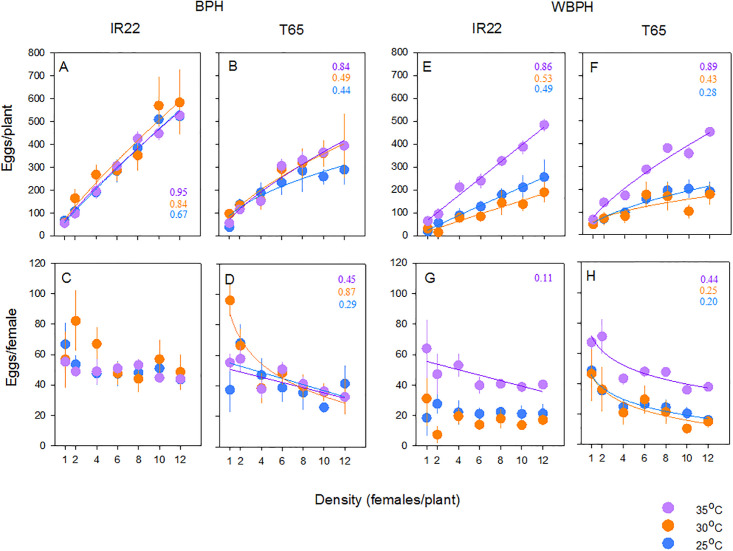
Relations between adult BPH (A,B) and WBPH (E,F) densities and the total number of eggs laid on IR22 (A,E) and T65 (B,F). The numbers of eggs laid per female BPH (C-D) and WBPH (G,H) on IR22 (C,G) and T65 (D,H) are also indicated. Bioassays were conducted in environmental chambers set at 25°C (blue symbols), 30°C (orange symbols) and 35°C (purple symbols). Means are indicated with standard errors (N = 5). Numbers are R2 values for best fit curves (as indicated; see S1 and S2 Tables).